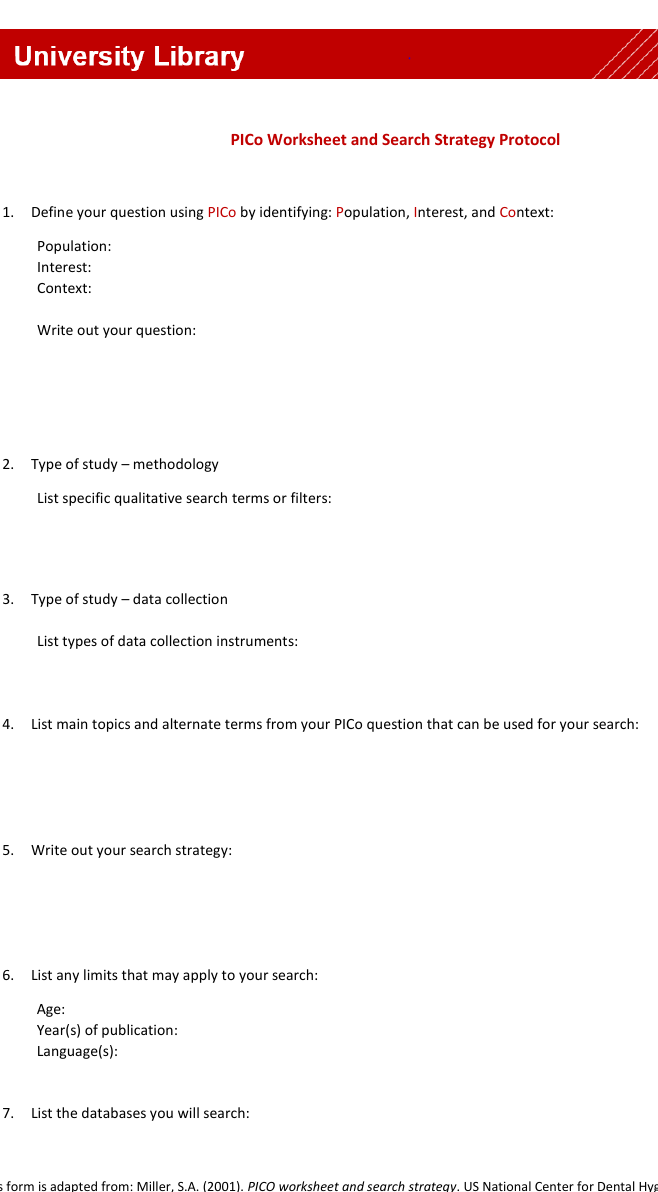
Figure A1. PICo Framework, adapted by Murdoch